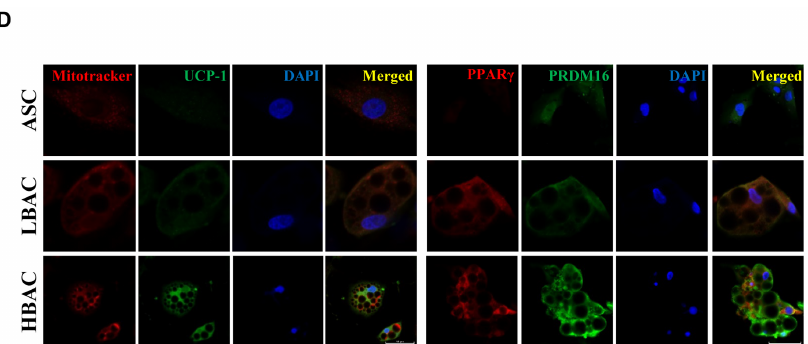
Figure 2. Beige adipocyte differentiation of rat adipose-derived stem cells. ( A ) Representative microscopic images of adipocytes stained with ORO (magnification, × 100, Scale bar = 100 µ m). ( B ) Assessment of the mRNA expression of browning markers by qPCR. ( C ) Validation of differen- tially regulated browning markers by immunoblot analysis. The intensity of each band was quantified with ImageJ software. The data are shown as the mean ± standard error of the mean ( n = 3). * p < 0.05, ** p < 0.01, and *** p < 0.001 vs. ASC. ( D ) Assessment of the expression of browning markers by immunofluorescence staining. Scale bar = 50 µ m. UD means “undifferentiated”.